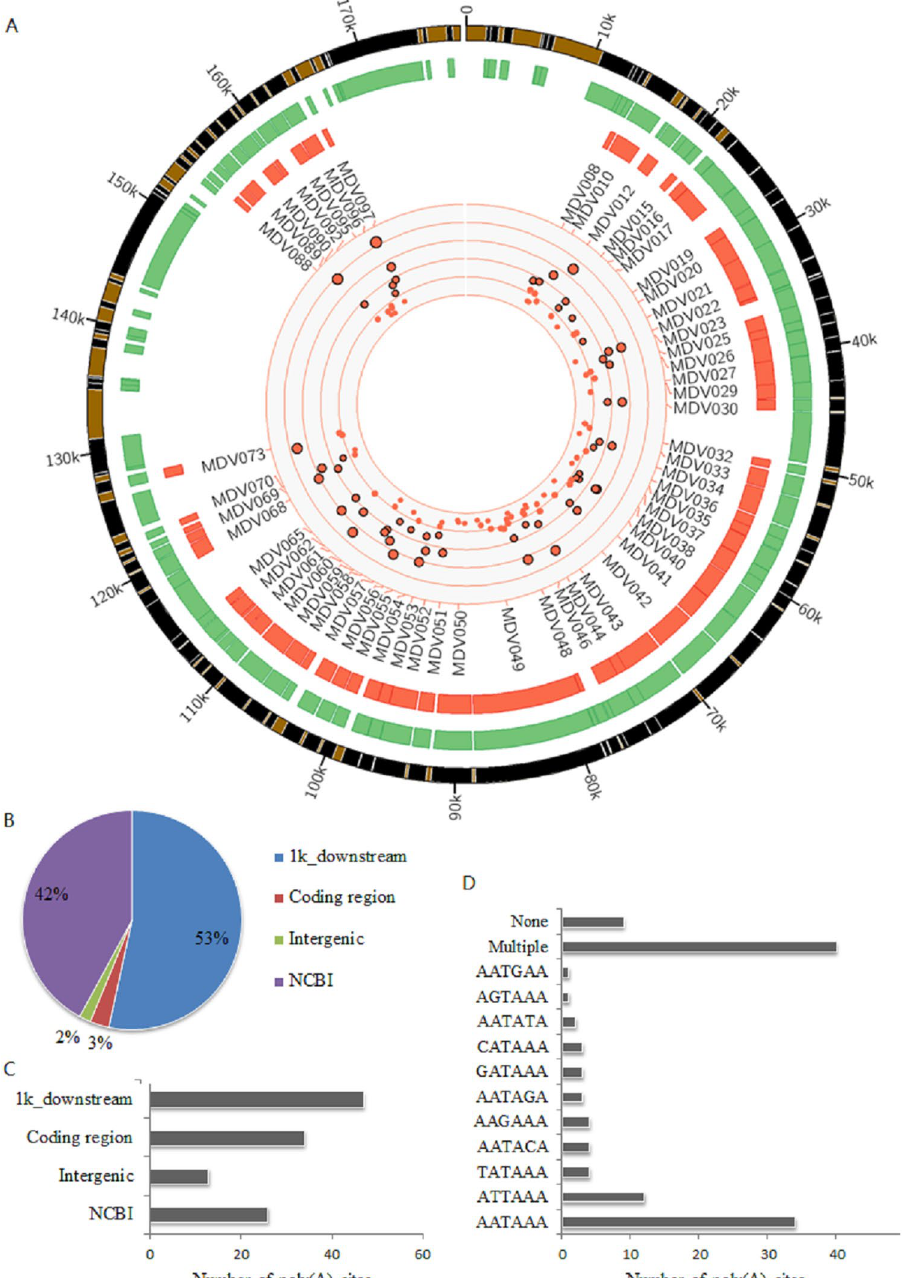
Figure 3. Sequencing reads and poly(A) sites in viral genes. ( A ) Landscape of APA sites profiling for viral genes. The track with green color represents the genome annotation from NCBI. The track with red color represents the expressed genes in our analysis. The red points in the center are the sequenced poly(A) sites in the genome and those with black stroke-color represent that their supporting reads are larger than 100. ( B ) Genomic locations of sequencing reads. The genomic annotation of virus was downloaded from NCBI and the 3 ′ UTR tail of these genes were annonated as NCBI. ( C ) Distribution of poly(A) sites in genome. ( D ) Signal using of poly(A) sites. If none of common hexamers was identified in upstream of poly(A) sites, it was classified into none